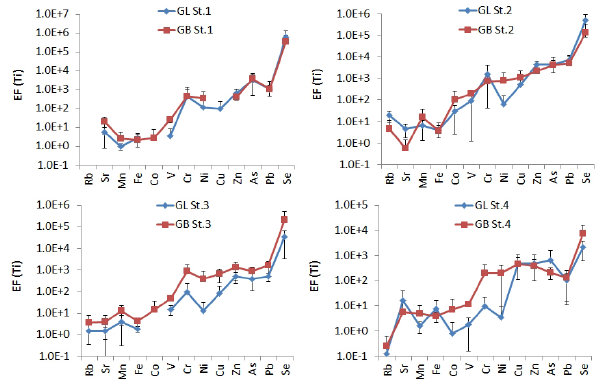
Figure 5. Size-resolved enrichment factor analysis of aerosol trace metals at the valley stations. Plotted values are averaged over all FCEs with their respective standard deviations plotted as error